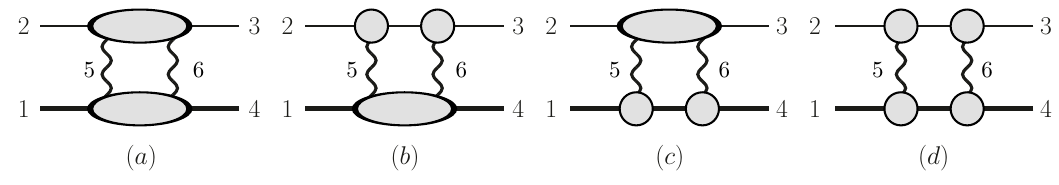
Figure 5 . Appropriate residues of the two-particle cut (a) give the triple cuts (b) and (c), and the quadruple cut (d). The thick straight line corresponds to the spinning particle, the thin straight line to the scalar, and the wiggly lines to the exchanged gravitons. All exposed lines are taken